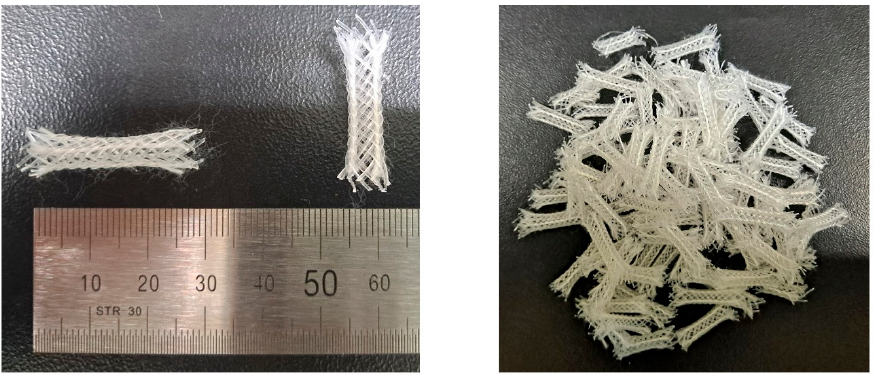
Figure 1. Photographs of the mesh tube filter media employed in this study.